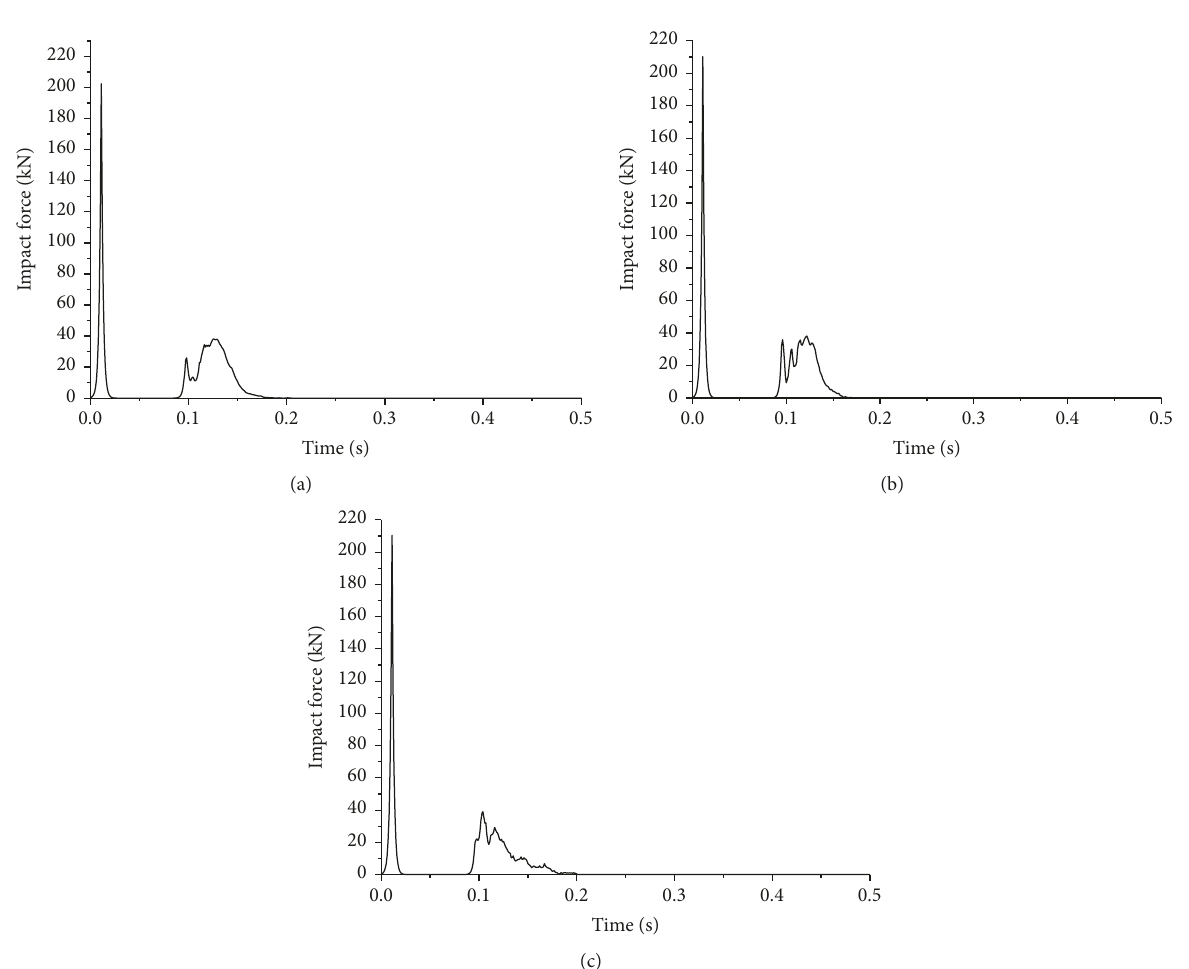
the bottom of the wall. The maximum stress appears at the fixed supports connected to the